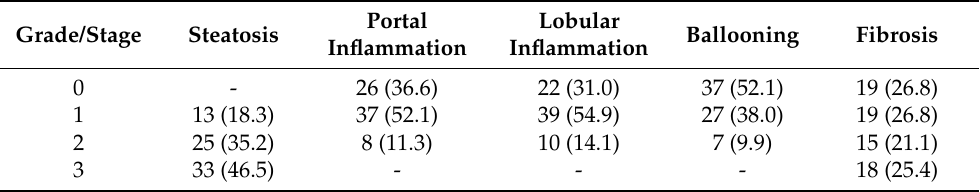
Table 2. Histologic evaluation of NAFLD in the study group. Numbers in brackets represent frequencies (%) of histologic findings in the study